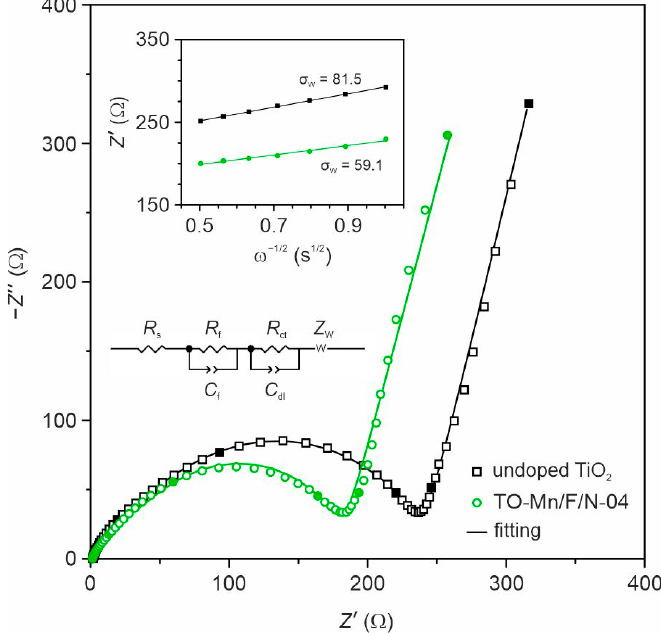
Figure 9. EIS spectra for undoped TiO 2 and TO-Mn/F/N-04 electrodes in the half-cells registered at 3 V (frequencies of 0.1, 1, 10, 100, and 1000 Hz are marked with filled symbols). The insets show EEC applied for fitting and plots of real impedance against the inverse square root of the angular frequency used for estimation of the Warburg factor.